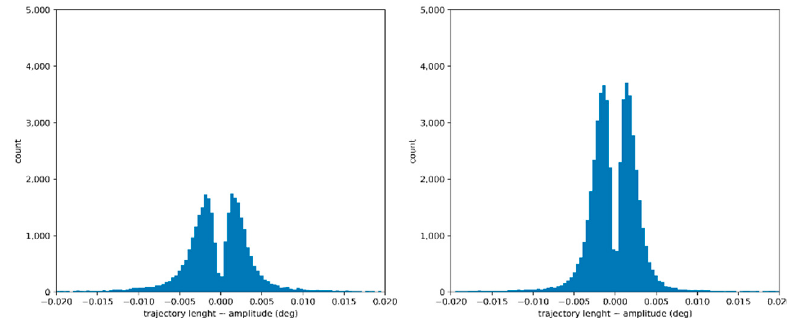
Figure A15. Histogram of the amplitude segments for the painting 4 dataset.